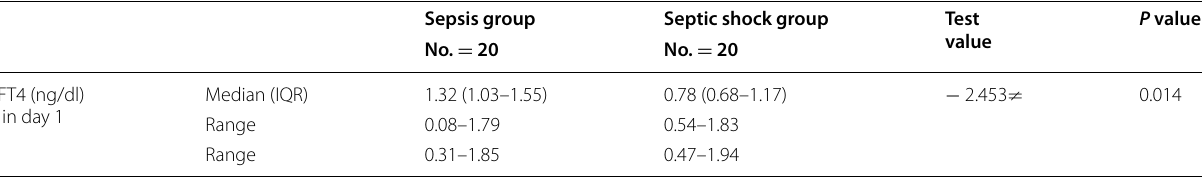
Table 4 Comparison between sepsis and septic shock regarding the thyroid hormones in day 1 of